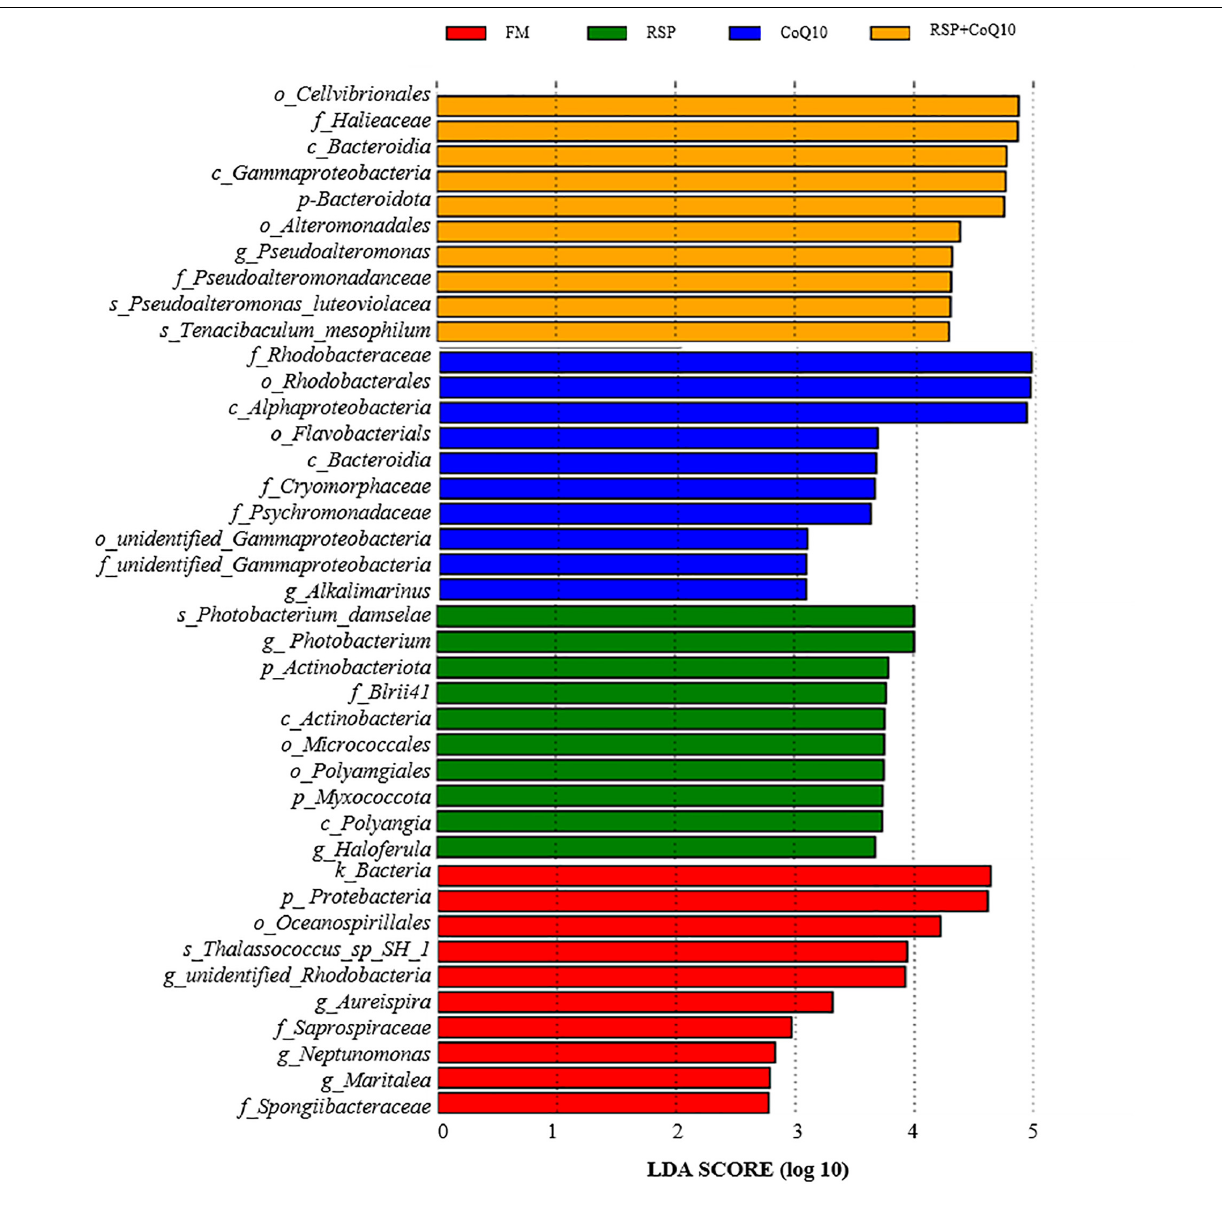
FIGURE 4 | Identified differentially abundant taxa between four diet treatments from by linear discriminant analysis coupled with LEfSe (LDA > 2.5, P < 0.05). Yellow box: enriched in FM diet, blue box: enriched in RSP diet, green box: enriched in CoQ10 diet, red box: enriched in RSP + CoQ10 diet. LDA, linear discriminant analysis; LefSe, LDA effect